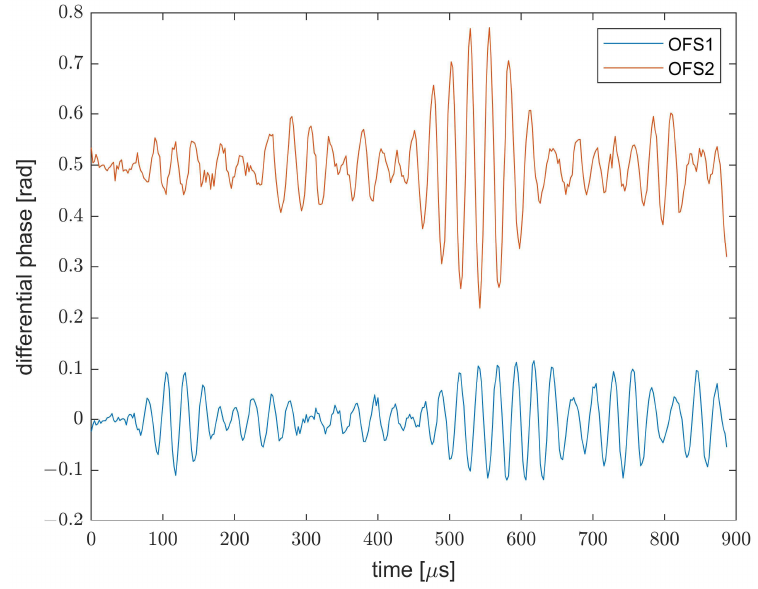
Figure 3. ϕ-OTDR signals acquired along the OF1 and OF2 fiber strands. The signal from OF2 has been vertically shifted by 0.3 rad for clarity purposes. been vertically shifted by 0.3 rad for clarity